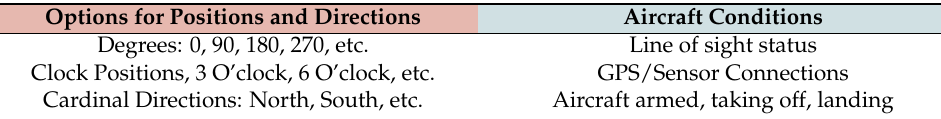
Table 5. Examples of communications that require